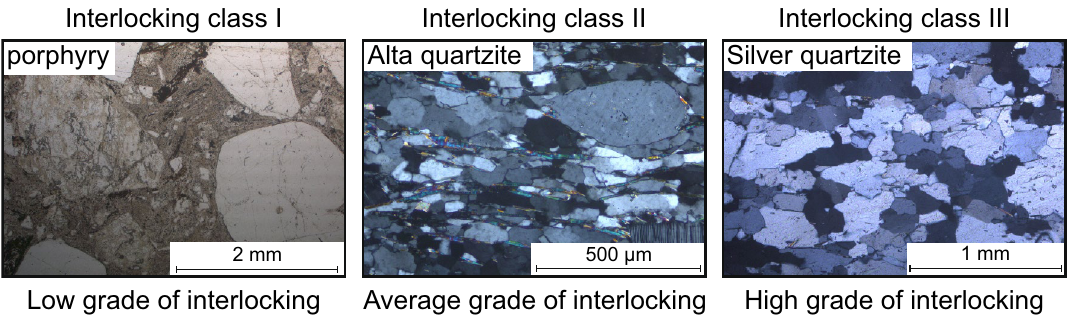
Fig. 3 Examples for the three interlocking classes used in this investigation shown using thin